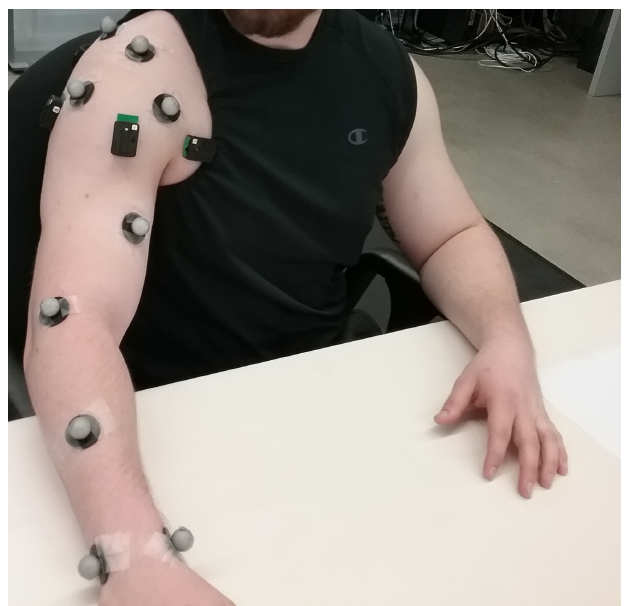
Figure 2. Experimental setup and marker placement.